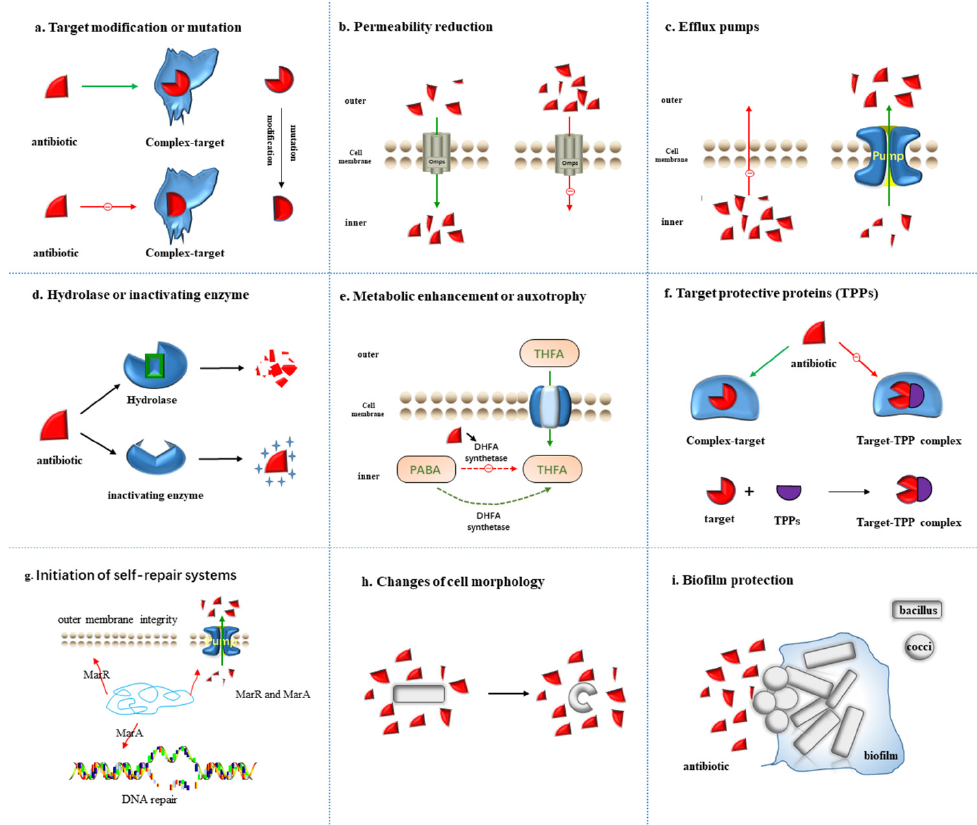
Figure 1. Nine resistance mechanisms of bacteria to antibiotics: ( a ) Target modification or mutation; ( b ) Permeability reduction; ( c ) Efflux pumps; ( d ) Hydrolase or inactivating enzyme; ( e ) Metabolic enhancement or auxotrophy; ( f ) Target protective protein; ( g ) Initiation of self-repair systems; ( h ) Changes of cell morphology; ( i ) Community cooperative resistance. The red triangle indicates antibiotics, and the resistance mechanisms of each figure are described in detail in the main text.